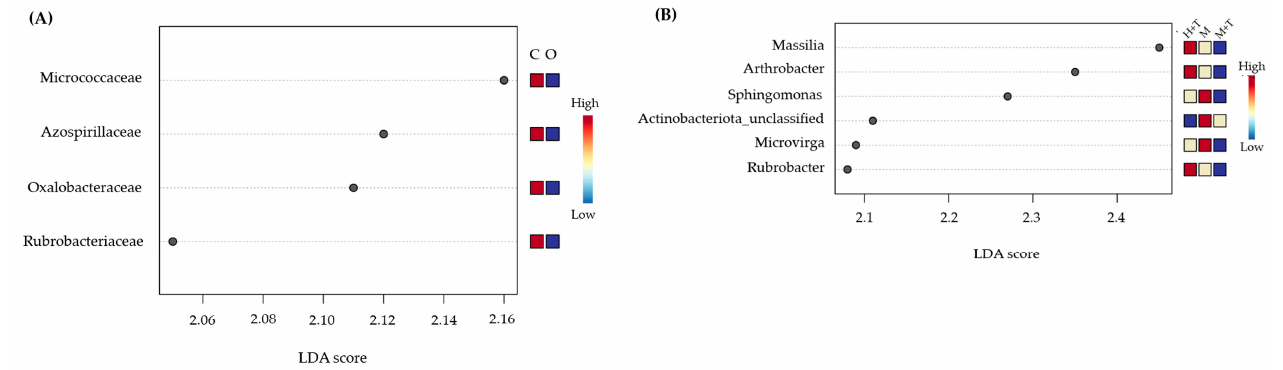
Figure 2. Linear discriminant analysis (LDA) scores and heatmap from blue (low) via white (medium) to red (high) of relative abundances in ( A ) conventional (C) and organic (O) systems and, ( B ) herbicide + tillage (H + T), mowing only (M) and mowing + tillage (M + T) cover managements.